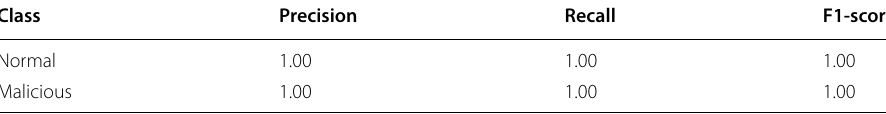
Table 19 Classification report of Random Forest Class